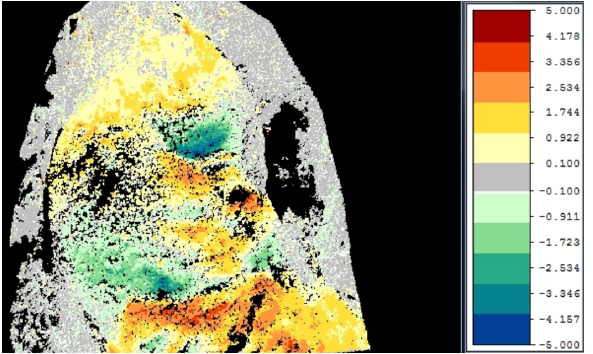
Figure 10. Change detection analysis comparing terrestrial (2015) and airborne laser scanning data (2011), indicating vertical elevation changes [m] due to rock glacier movement 3.2.2